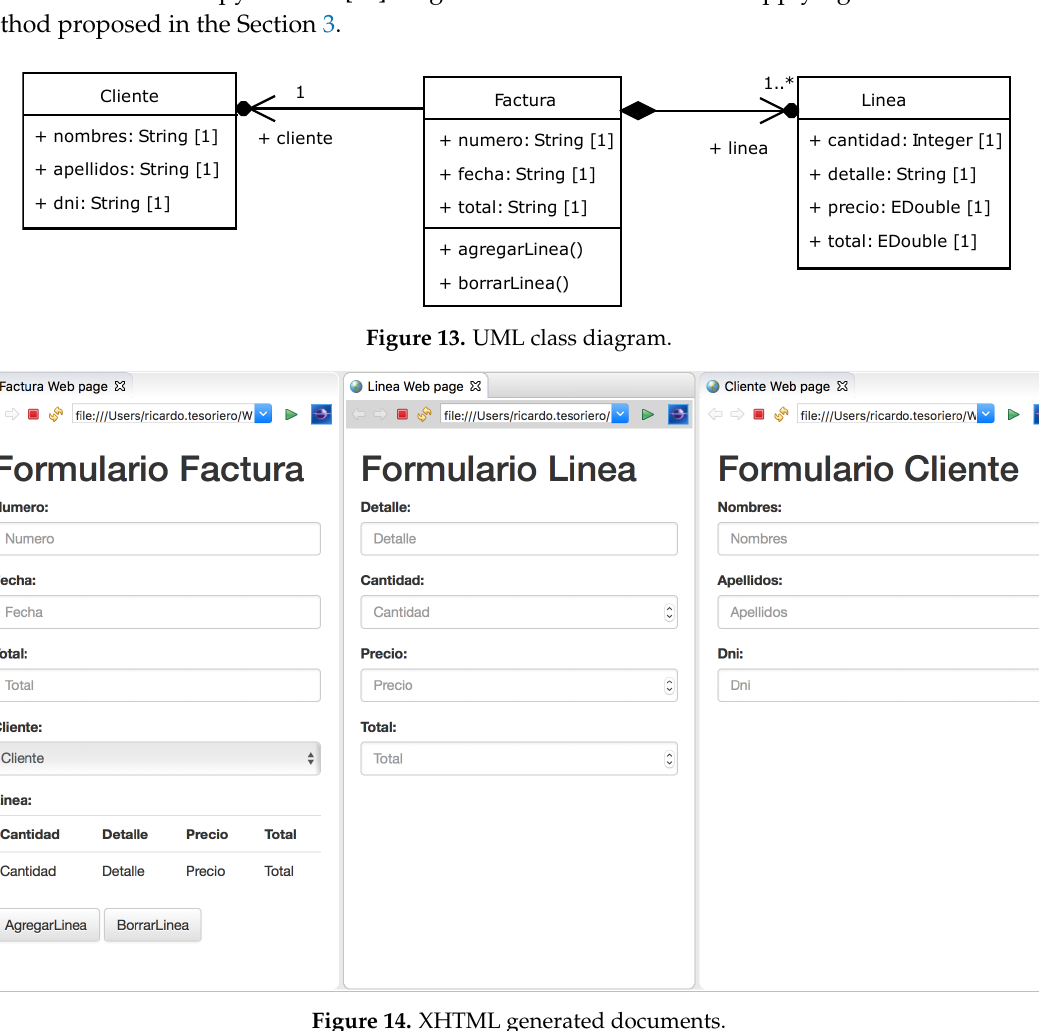
Figure 12. Comment generation template extension to TagML in ACCELEO.